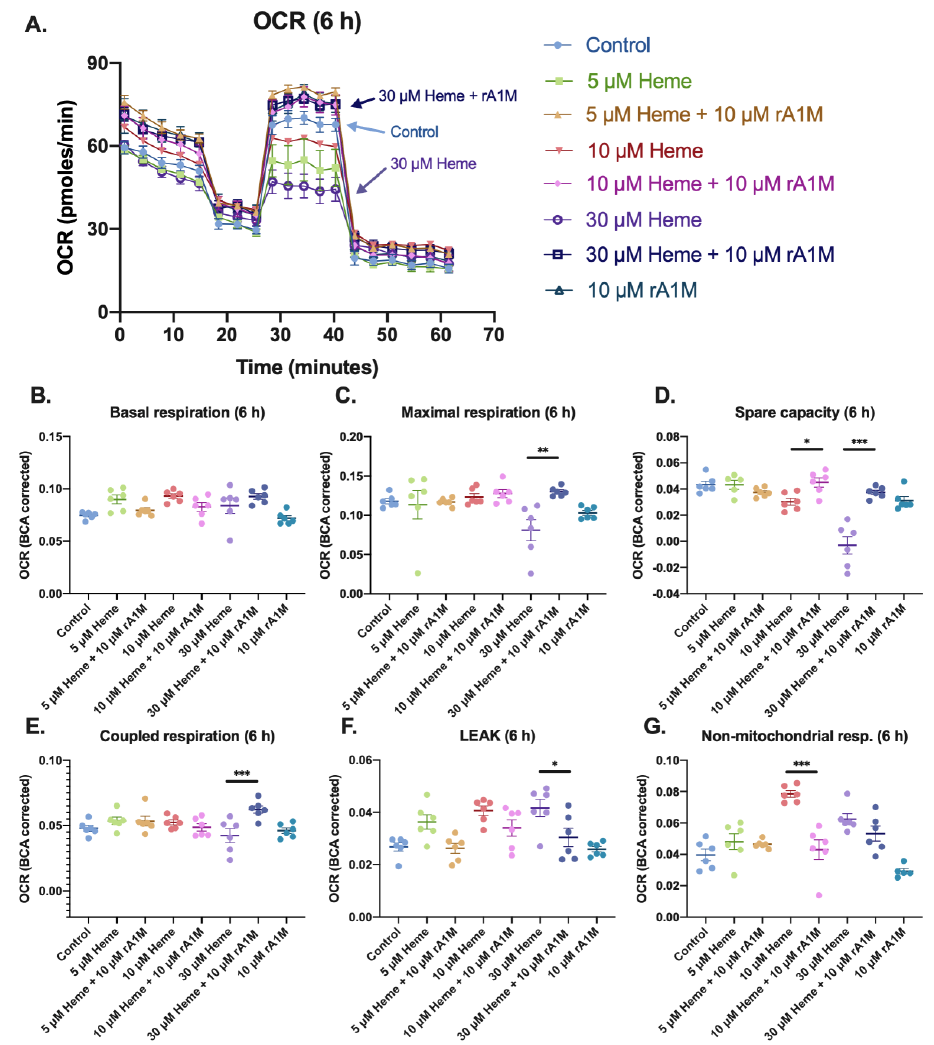
Figure 3. rA1M protects mitochondrial function after heme addition. Mitochondrial respiration ( A ) after incubation with heme (5, 10 or 30 µ M), with or without rA1M (10 µ M) after 6 h. Data are corrected for protein content (BCA), as described in the methods section, and presented as basal respiration ( B ), maximal respiration ( C ), coupled respiration ( D ), spare capacity ( E ), proton leak ( F ) and non-mitochondrial respiration ( G ). Values are from a representative experiment and presented as mean ± SEM ( n = 6, analyzed on the same plate). Di ff erences between groups were analyzed using one-way ANOVA with post hoc Sidak ( B – F ), * P < 0.05, ** P < 0.01, *** P < 0.001.